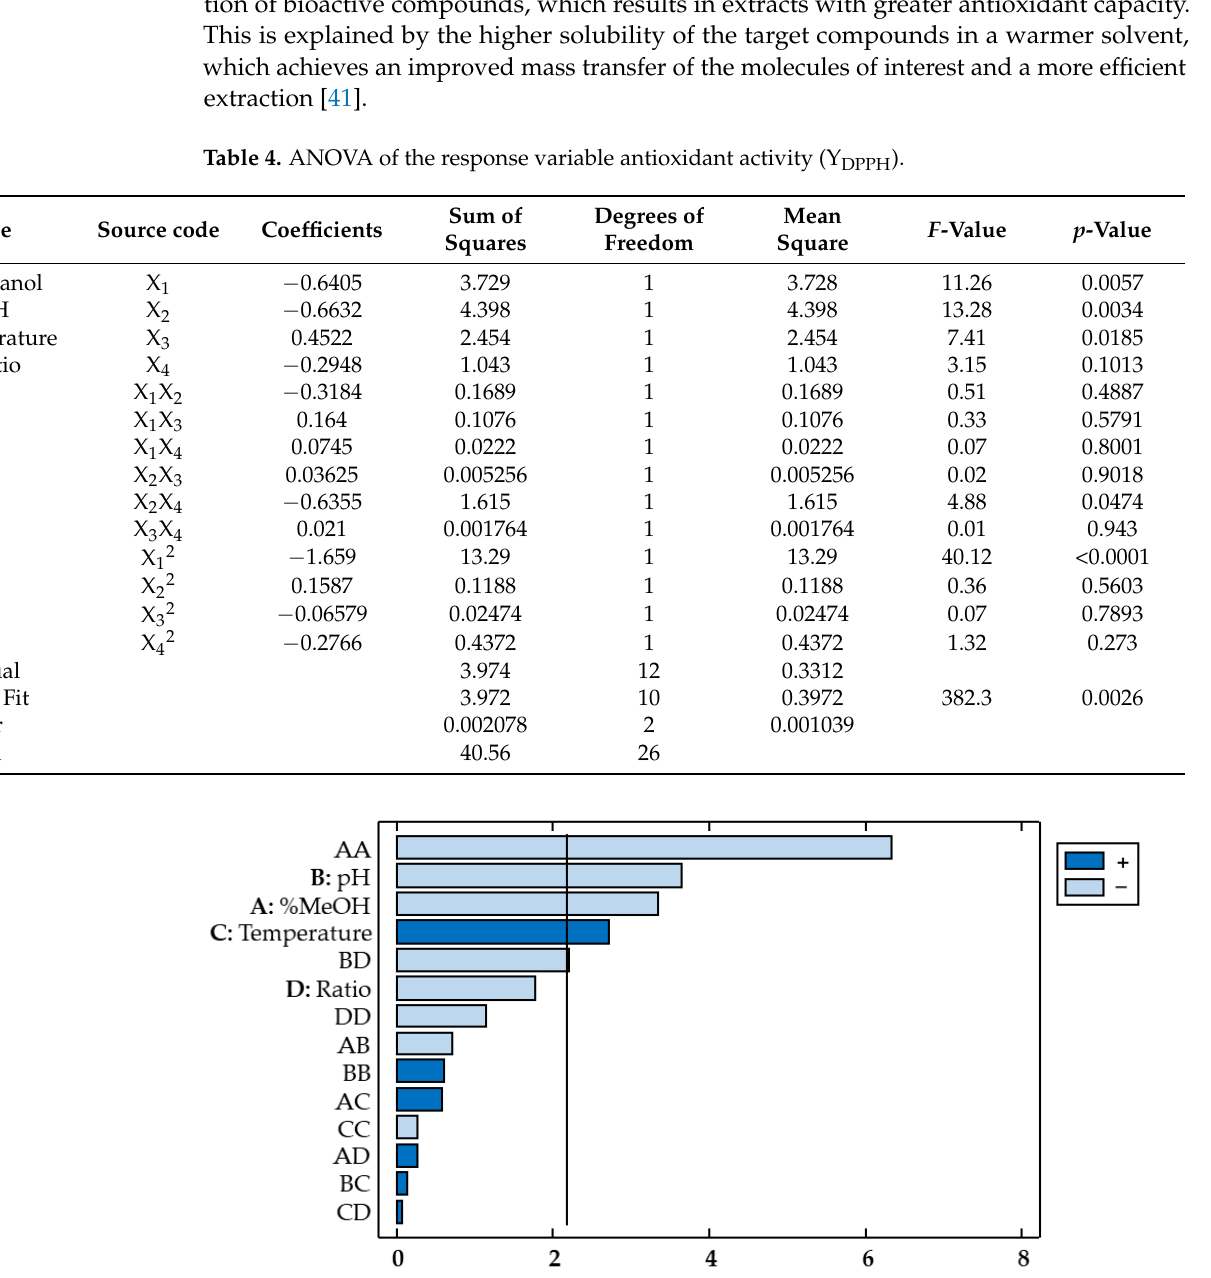
Table 4. ANOVA of the response variable antioxidant activity (Y DPPH ).